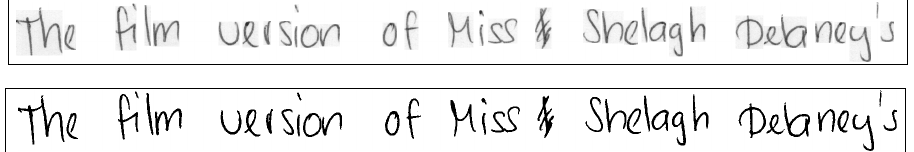
Figure 3. Raw line segmented images of the IAM dataset and an enhanced version of the image after applying a supplementary OpenCV-based python